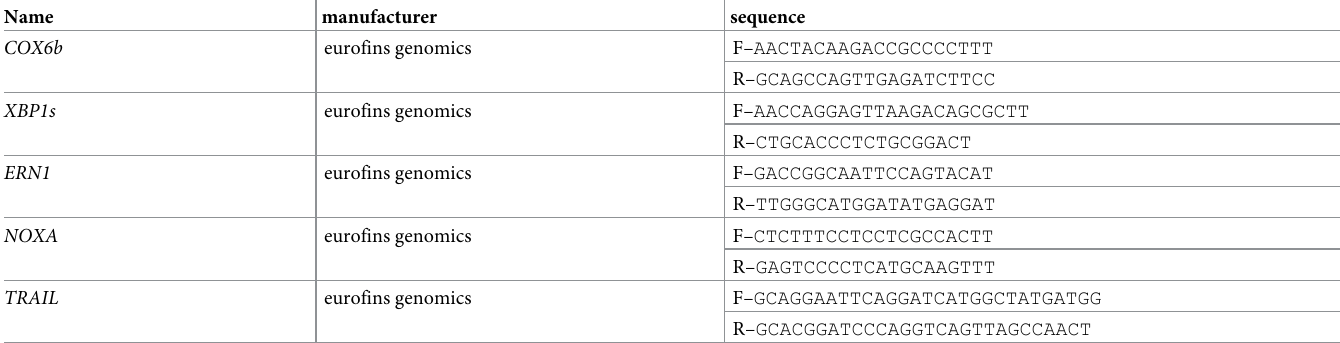
Table 2. Primers and sequences